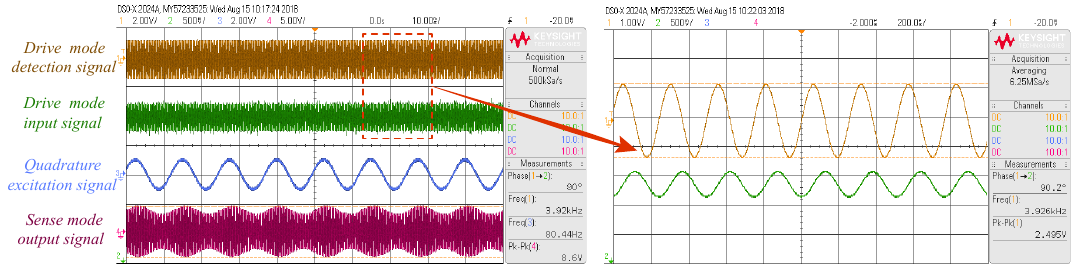
Figure 13. The test curves of the frequency tuning system.